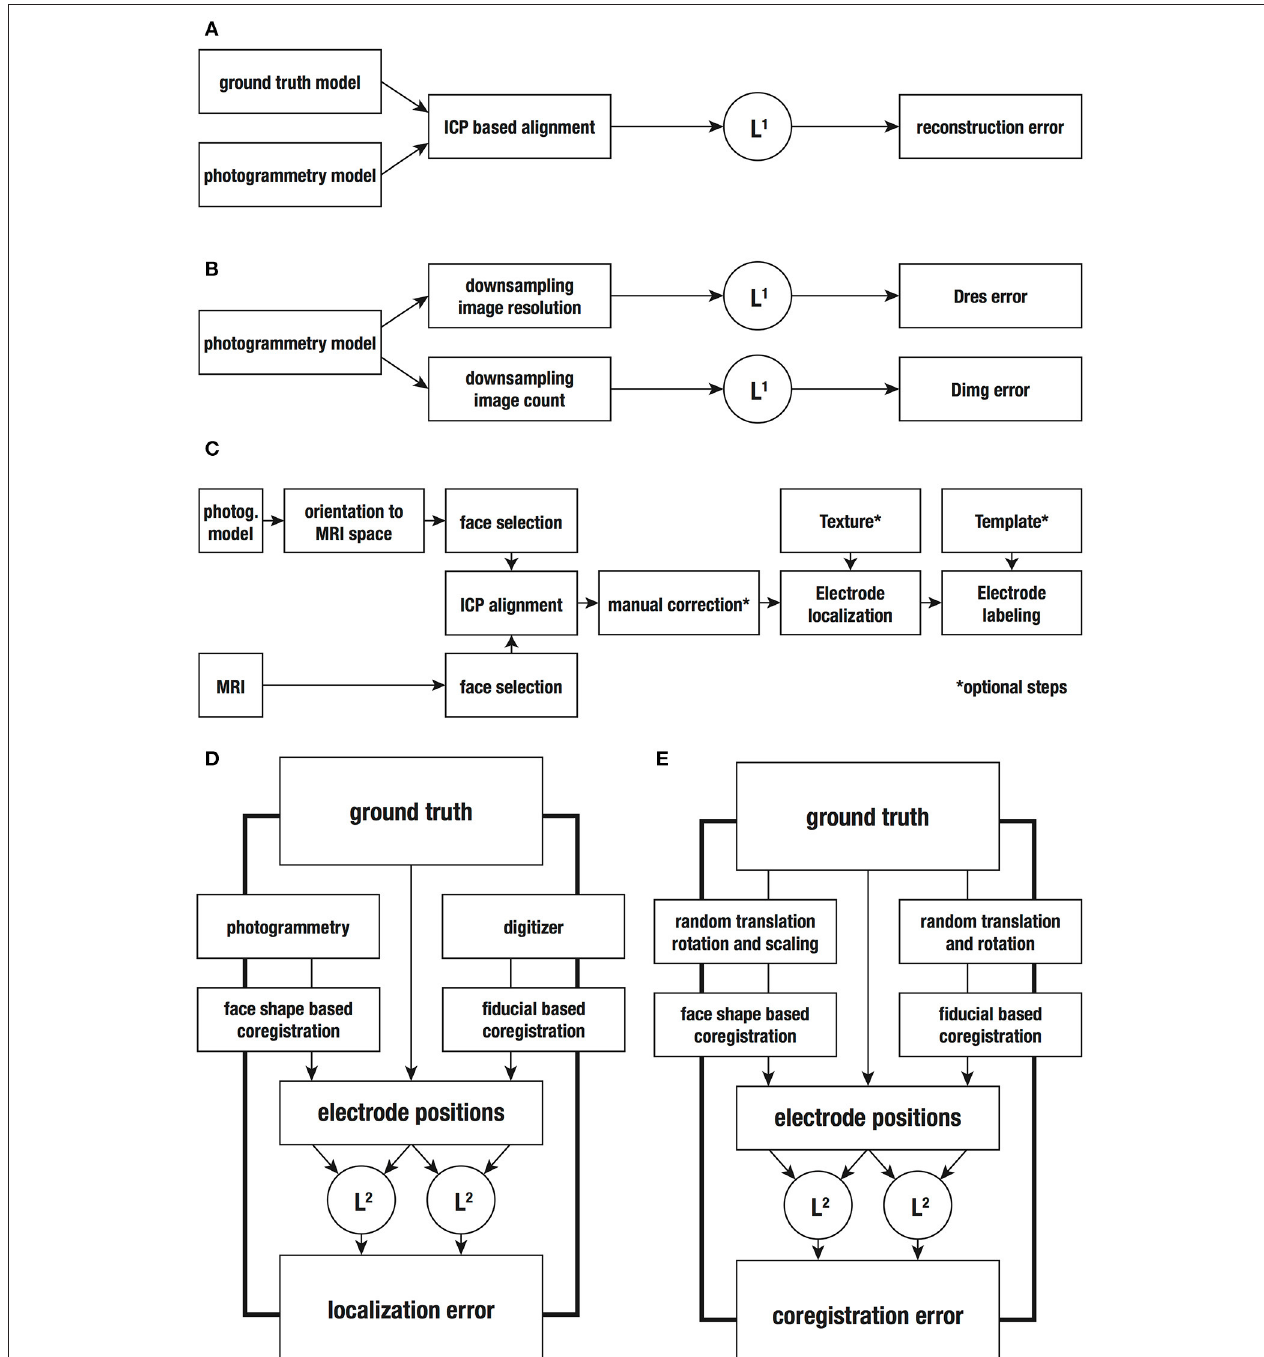
FIGURE 3 | Workflows followed for application and evaluation of the respective methods. (A) Comparison between the ground truth and the photogrammetry-based 3D model to obtain the reconstruction error. (B) Evaluation of the downsampled models regarding image count (Dimg) or image resolution (Dres) by comparison with the ground truth model to obtain respective reconstruction errors. (C) Application workflow to obtain electrode positions from photogrammetry-based 3D models. (D) Determination of electrode positions with a digitizer and the photogrammetric method, and comparison with the ground truth positions to obtain the localization errors. (E) Procedure for evaluating the coregistration accuracy. ICP, Iterative closest point algorithm; L 1 , L 1 -norm to compute the offset of each vertex in each orthogonal direction; L 2 , L 2 -norm to compute Euclidean distance between vertex points.